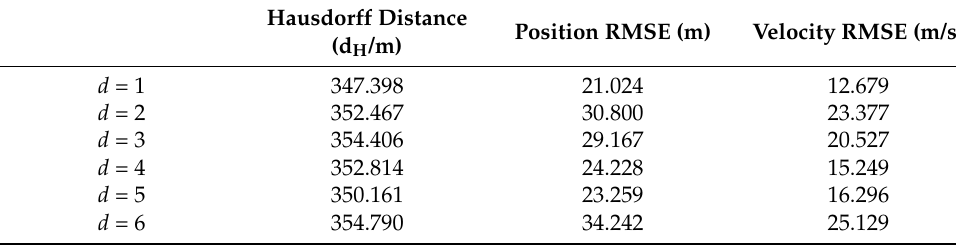
Table 2. The correction ability corresponding to different d